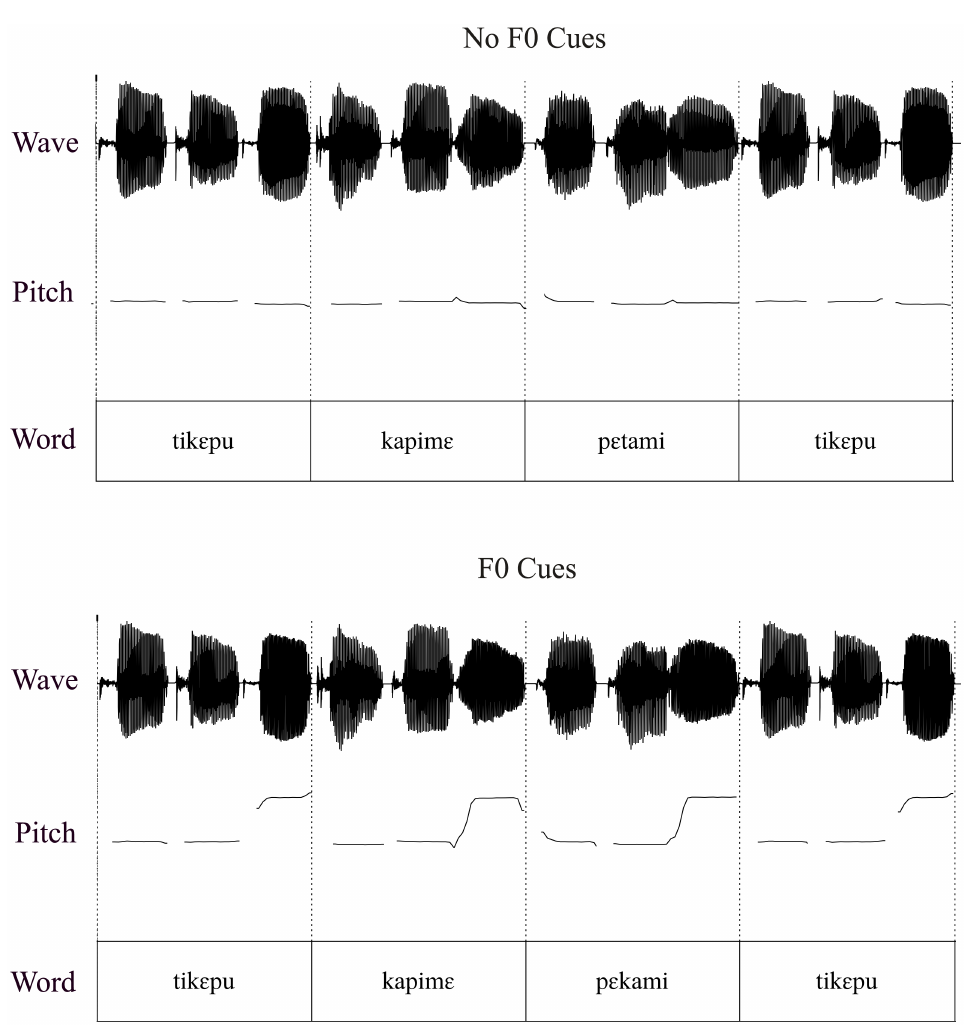
Fig 1. Schematic illustration of words in the AL without F0 cues (top panel) and the AL with F0 cues (bottom panel). In each panel, the top row represents the sound wave, the middlerow the pitch track, and the bottom row the